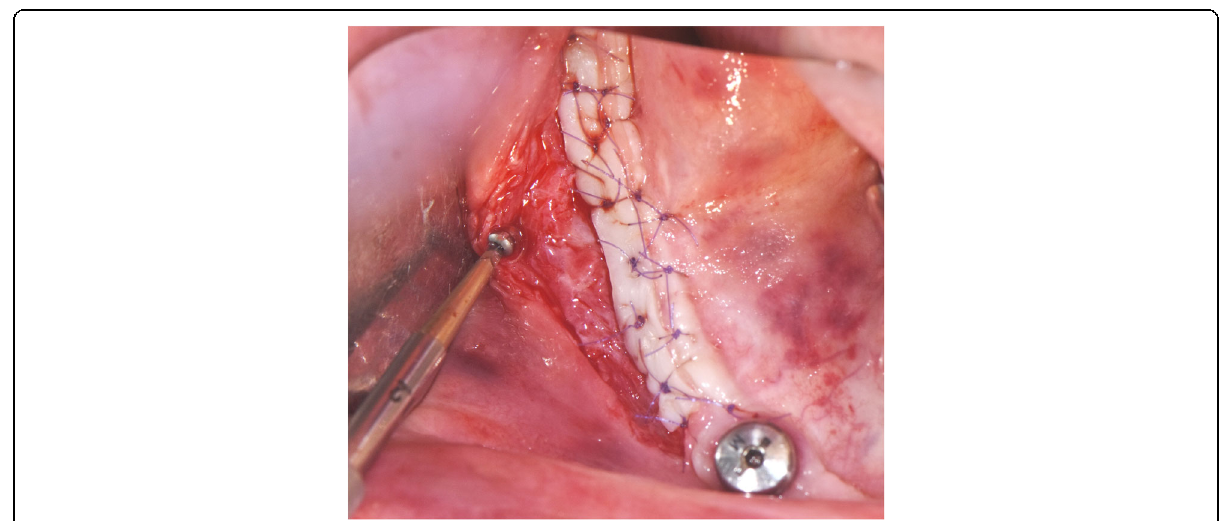
Fig. 10 Vestibuloplasty with free gingival graft is performed. Notice the titanium mini-screw that indicates the neurovascular bundle ’ s position